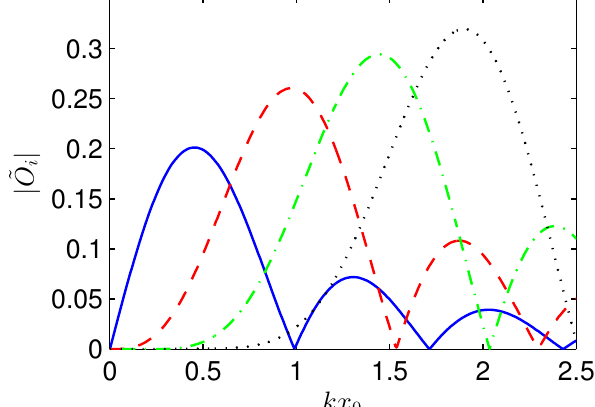
Figure 8. Overlap integral relevant to phonon detection in a transversely pumped cavity (cid:82) ˜ O h g ( x ) h ( x ) [ u = 1 / ( g ) ( x ) − v ( x )] ψ ( x ) dx , as a function of the cavity wavenumber i 0 0 i i 0 k , where g ( x ) = g is uniform. The condensate is centered at x = 0 , sin( kx ) and h ( x ) = h 0 0 a node of the cavity light amplitude. We show such overlaps for the four lowest energy odd Bogoliubov modes i = 1 (blue, solid), i = 3 (red, dashed), i = 5 (green, dot-dashed), and i = 7 (black, dotted). Note that the symmetry of the system implies ˜ O numbered modes, and the overlap with the condensate density of Equation (39) also vanishes in this